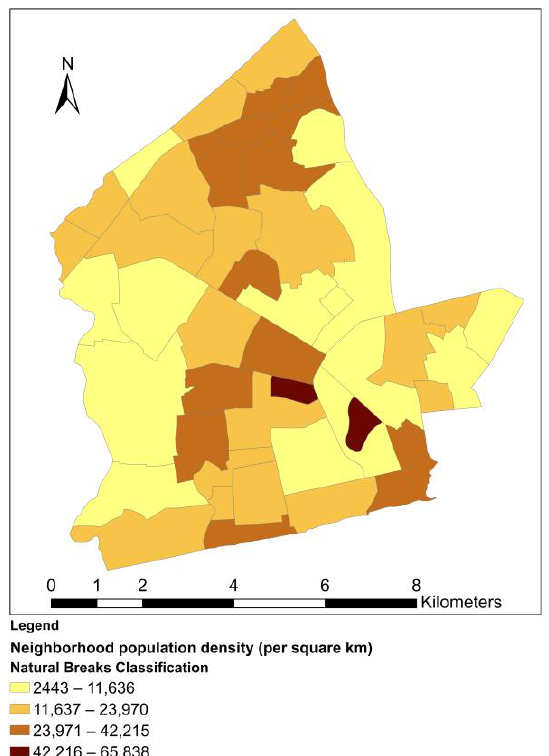
Figure 6. Distribution of neighborhood population density.